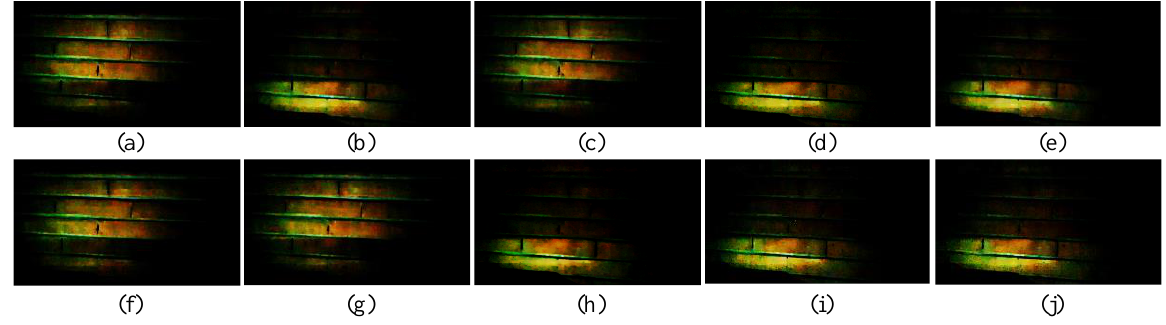
Figure 8. The block diagram of the laboratory prototype used for testing the communication system. Ten consecutive video frames from the captured video are illustrated in Figure 9 to offer the reader details about the functioning of the system. The number of images that are presented is chosen to be relevant to the reader while avoiding overcrowding the paper. With the presented images, the detection of two consecutive symbols can be explained. The rest of the symbols contained in the whole video sequence are decoded in a similar way.